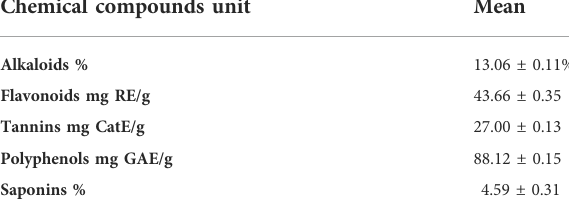
TABLE 4 Quantitative analysis of the aqueous extract of P. biglobosa